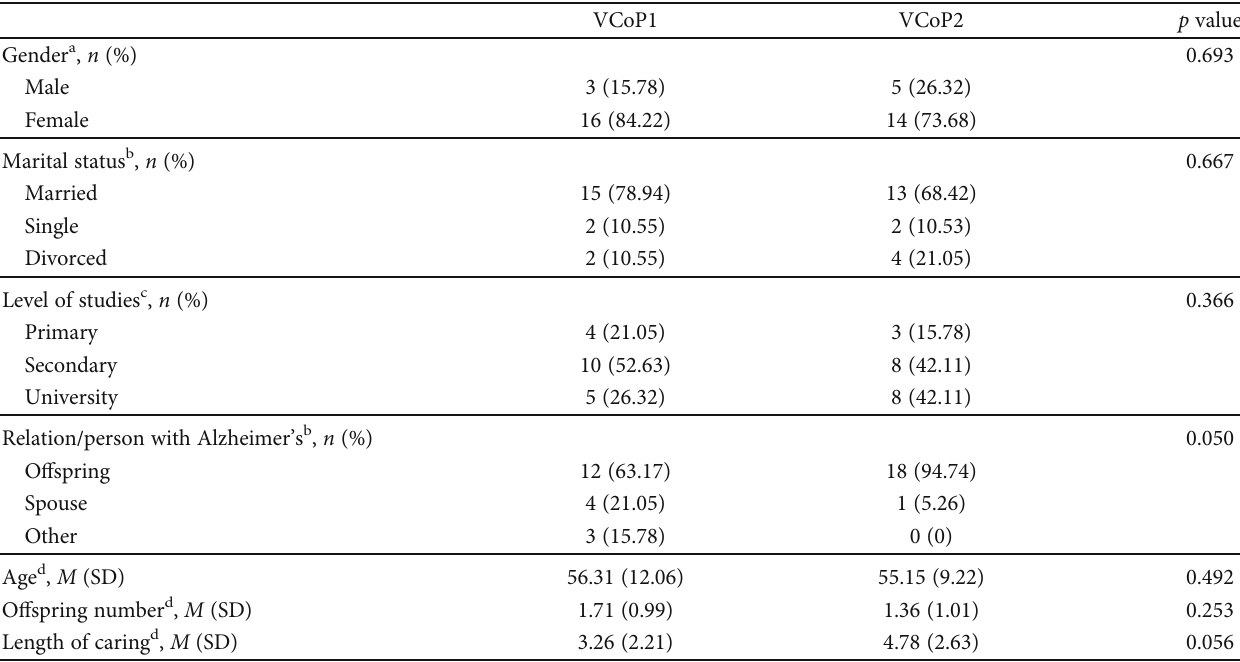
Figure 1: Samples of the App “ Estic amb tu — I ’ m With You ” screenshots. Table 1: Statistical di ff erences between demographic and caring values of the two